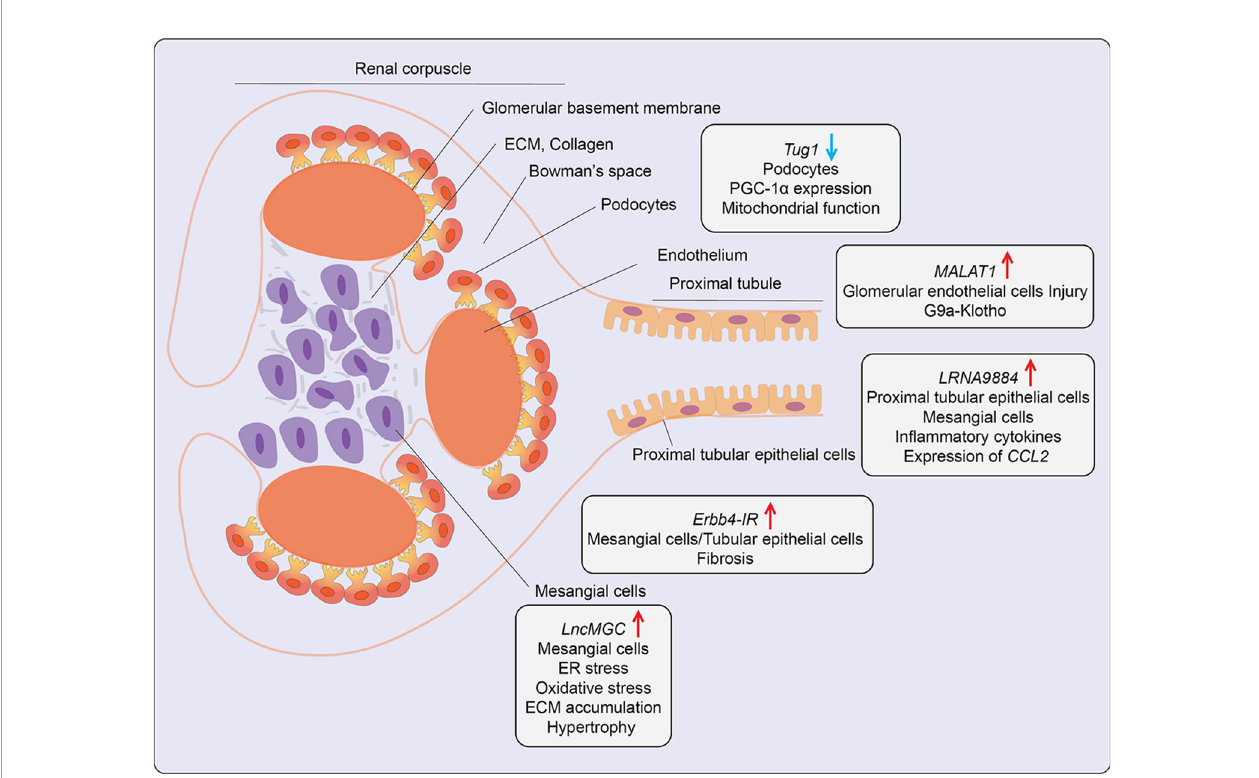
FIGURE 5 | Role of LncRNAs in diabetic nephropathy (DN). A schematic showing the roles of candidate lncRNAs with functions in the indicated kidney cell types during development of diabetic nephropathy. Arrows indicate the direction of changes in the expression or function. ER, Endoplasmic Reticulum; CCL2, C-C Motif Chemokine Ligand 2; ECM, Extracellular matrix; G9a, Histone H3-lysine 9-dimethyl-transferase; PGC-1 a , Peroxisome proliferator-activated receptor gamma coactivator